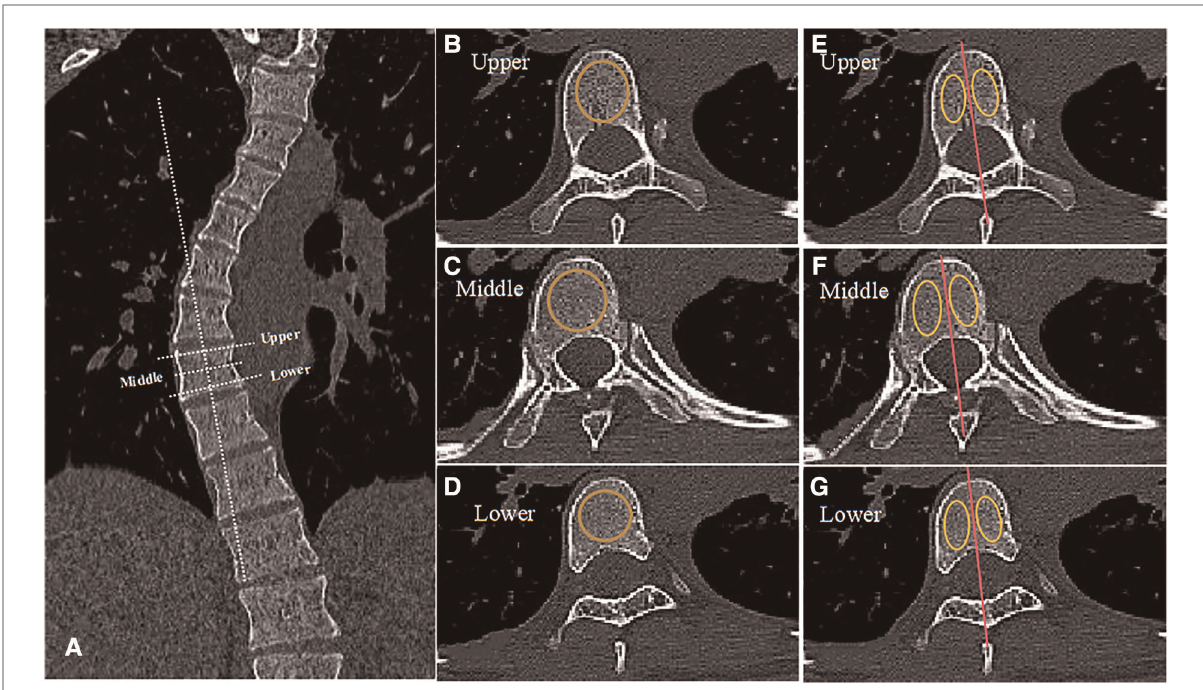
FIGURE 2 Measurement diagram of HU value. ( A ) The dashed white line represents the appropriate angulation on a reformatted workstation for obtaining the transverse CT image for each vertebra, displaying different planes. ( B – D ) The dotted orange circle represents the area we focused on in three different planes of the same vertebra: below the upper endplate of the vertebra, in the middle of the vertebra, and above the lower endplate of the vertebra. ( E – G ) We drew the red line to divide the vertebra into concave and convex sides through the spinous process as shown. The solid yellow circle represents the area we focused on for HU value